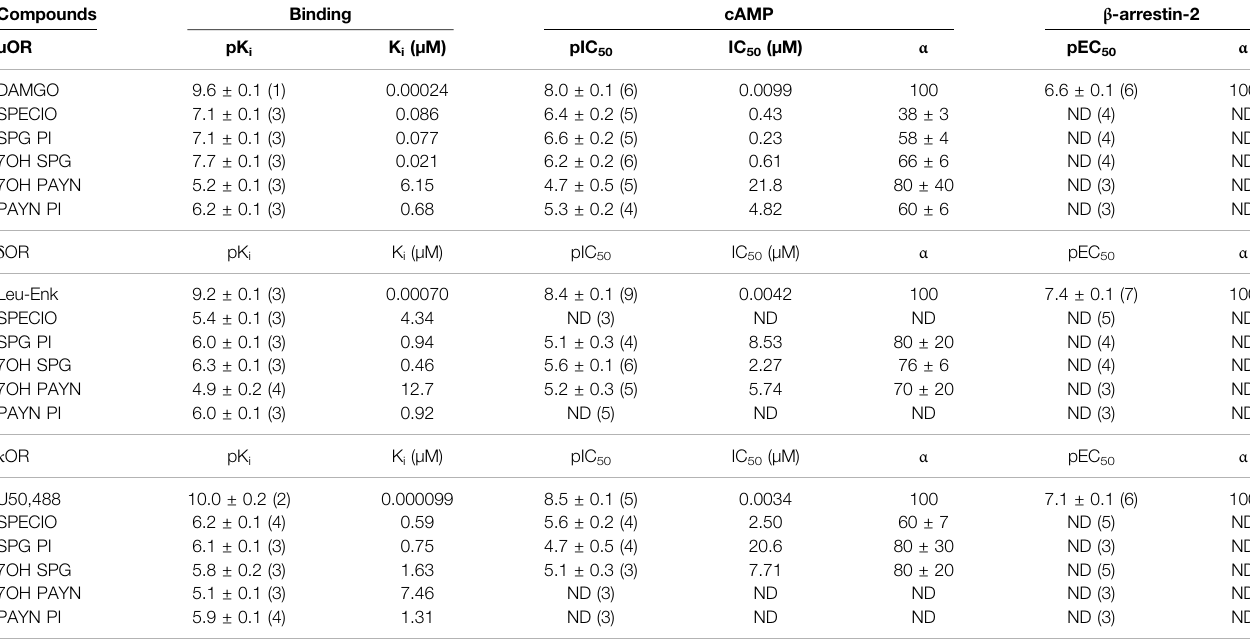
TABLE 1 | Pharmacological characterization of kratom derivatives at the µ, δ , and κ opioid receptors. Compounds